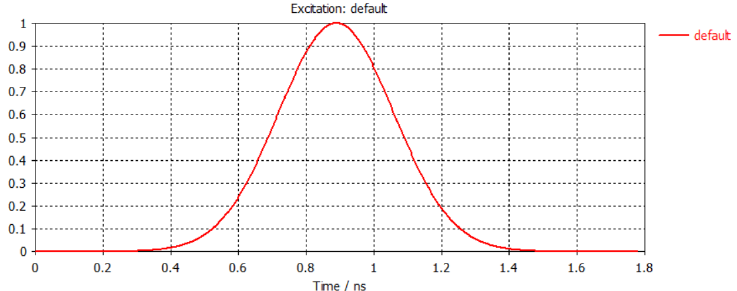
Table 1. The di ff erence between far-field and near-field.